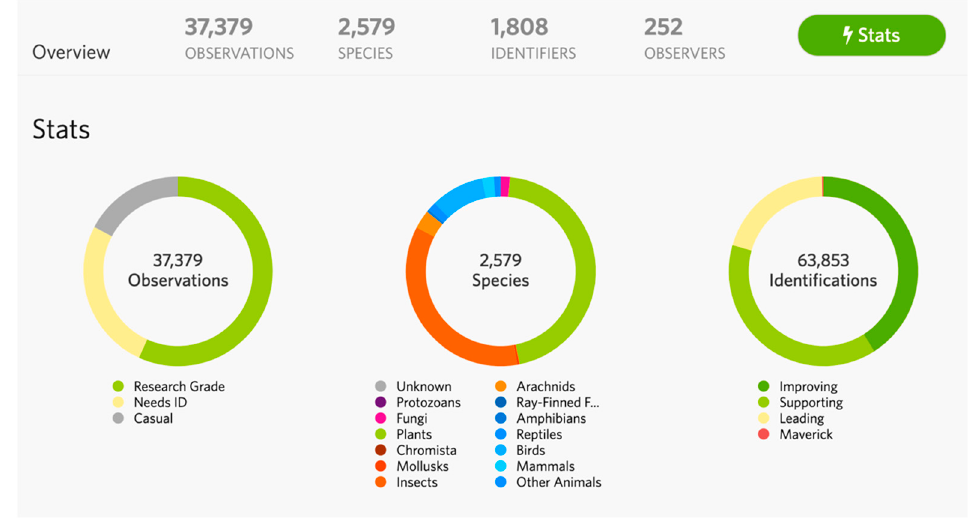
Figure 4. Screenshot from EcoFlora project page on iNaturalist website showing current project stats.